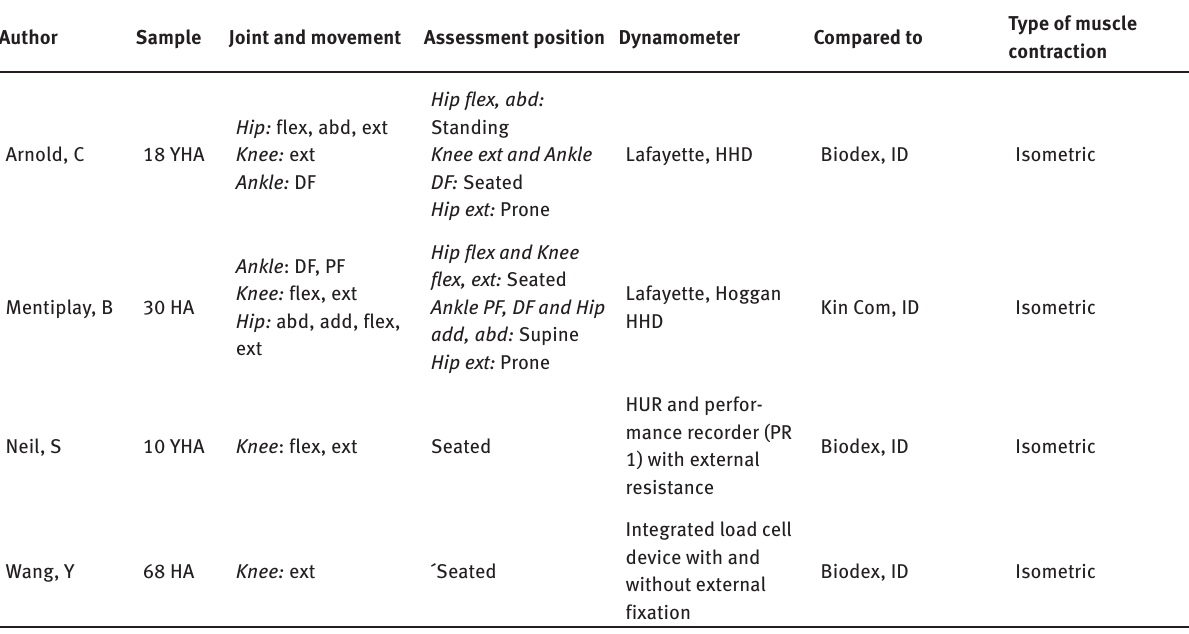
Table 3: Characteristics of selected studies analyzing concurrent validity between HHD and